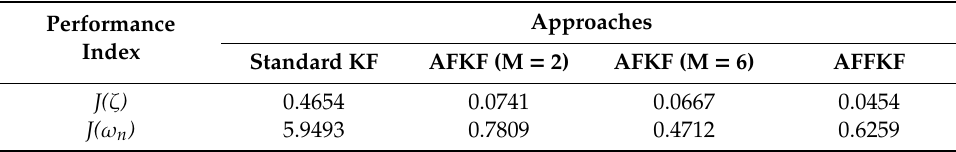
Table 3. Comparison of performance index for estimation of abrupt fault parameter.